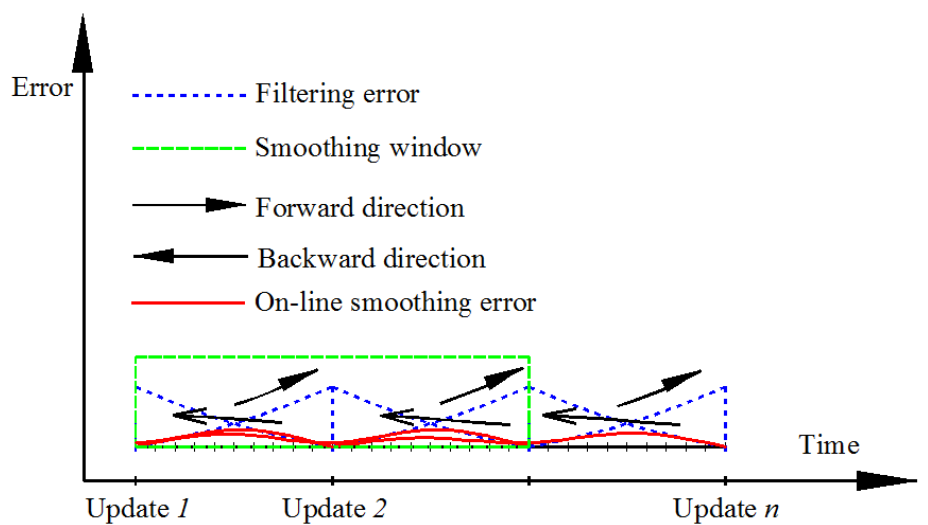
Figure 7. Window size in on-line